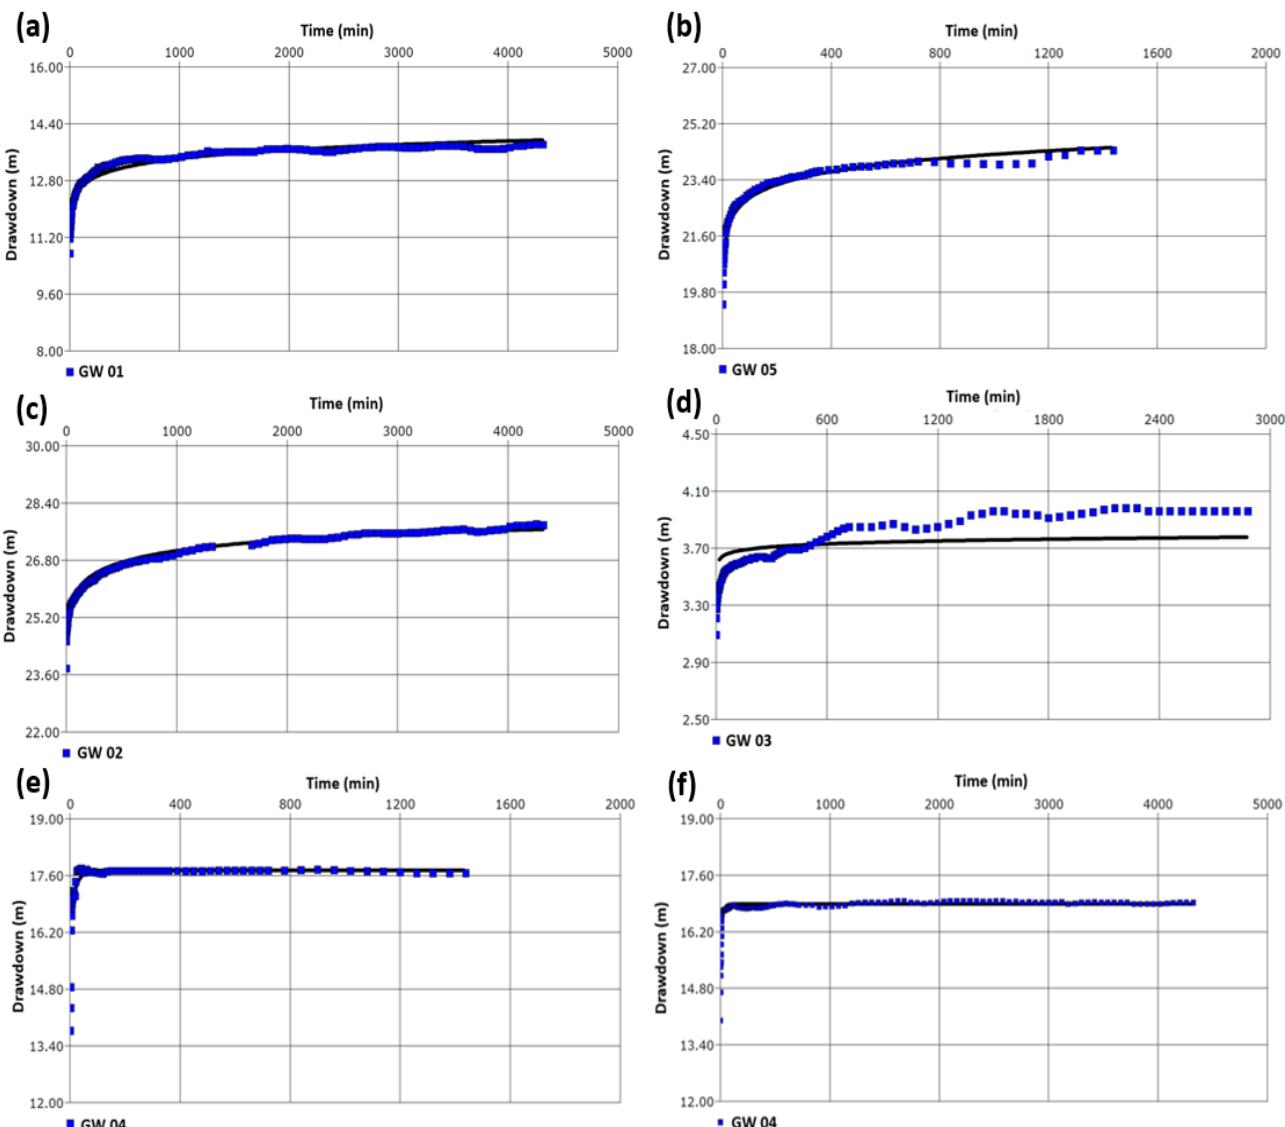
Figure 8. Examples of analyzing the pumping tests in ( a , b ) unconfined aquifer, ( c , d ) leaky confined aquifer and ( e , f ) deep confined aquifer.